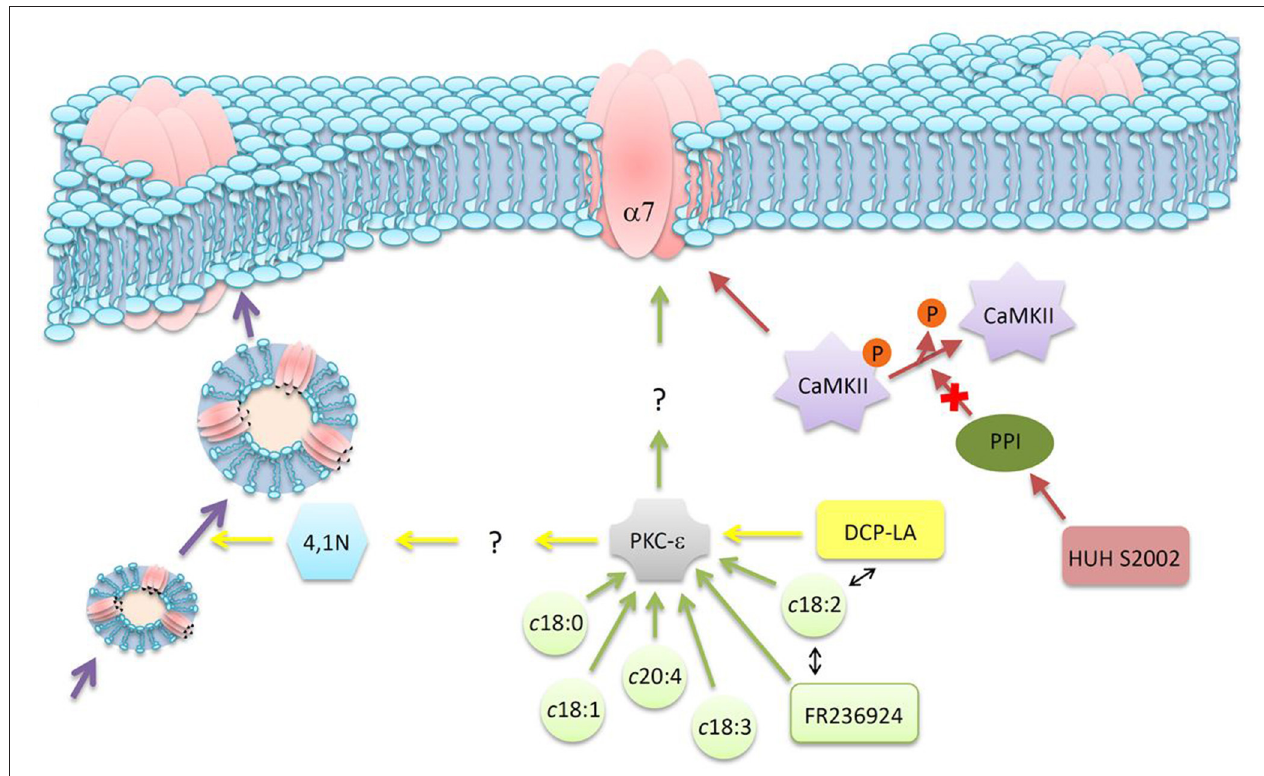
FIGURE 3 | Schematic diagram of indirect mechanisms of action of FFA on neuronal nAChR function. Different FFA, or their derivatives, can modulate α 7 nAChR through various signaling pathways. See text for details.